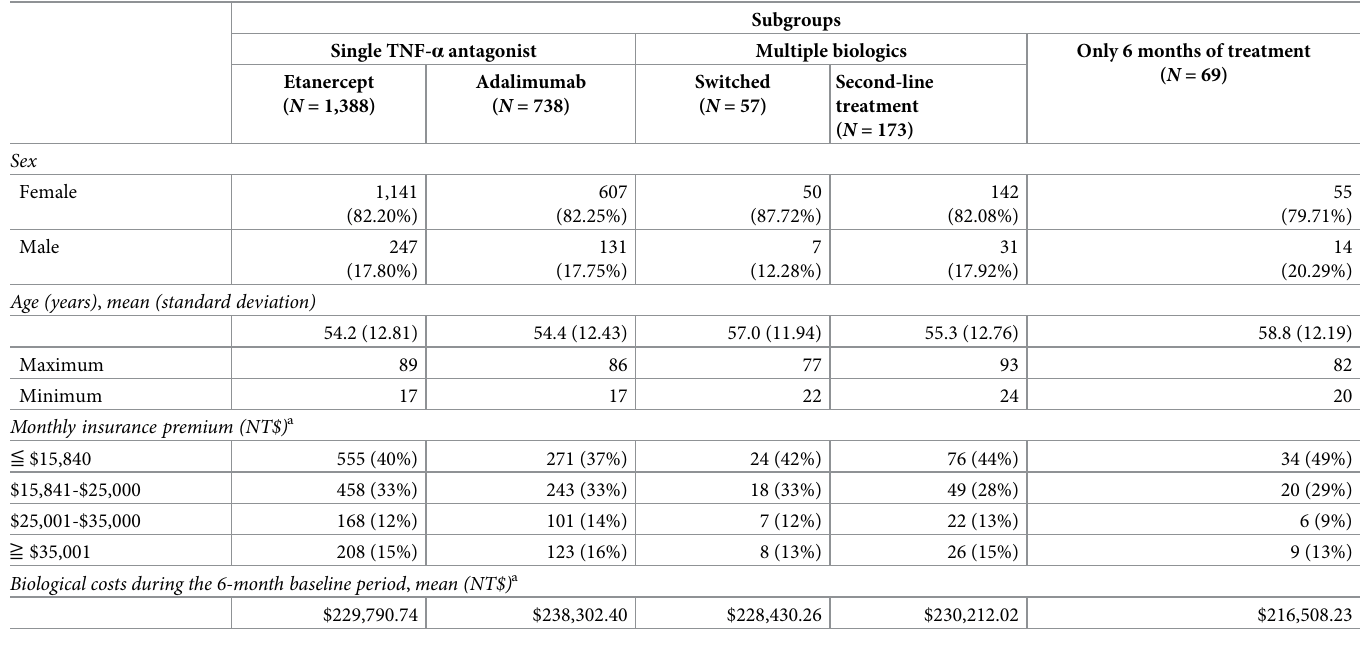
Table 1. Demographic characteristics and patterns of biologic therapies of patients with rheumatoid arthritis (RA). ( N =